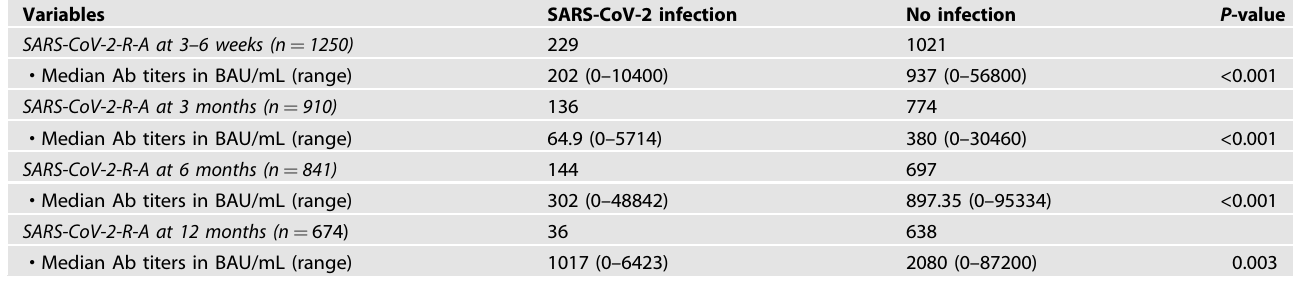
Table 4. Median test analyses of the SARS-CoV-2-R-A titers in BAU/mL at different serological time point assessments according to occurrence of breakthrough SARS-CoV-2 infection a